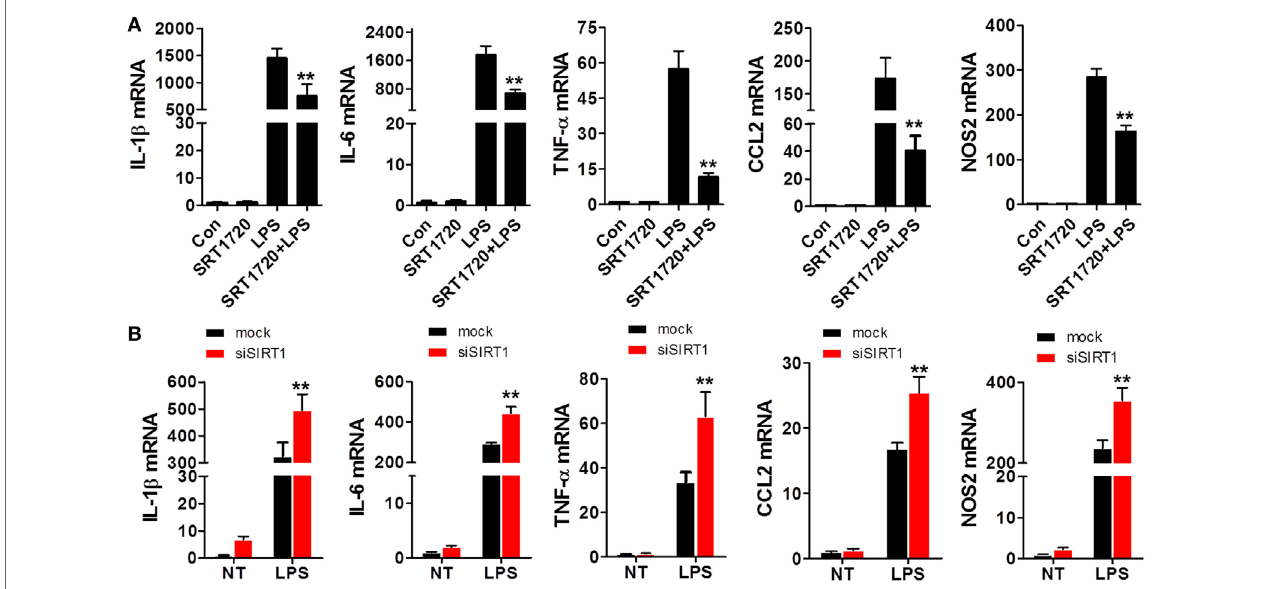
FigUre 2 | SIRT1 activation and inhibition led, respectively, to a decrease and increase in pro-inflammatory cytokines in macrophages. (a) RAW264.7 cells were treated with PBS (control) or SRT1720 or with lipopolysaccharide (LPS) or LPS + SRT1720, and then RT-PCR was performed to assess the expression levels of IL-1 β , IL-6, TNF- α , NOS2, and CCL2. **p < 0.01 compared with the LPS group; n = 6. (b) RAW264.7 cells were transfected with SIRT1 siRNA or mock siRNA and then the knockdown and control cells were treated with LPS or PBS (NT). The expression levels of IL-1 β , IL-6, TNF- α , NOS2, and CCL2 were examined